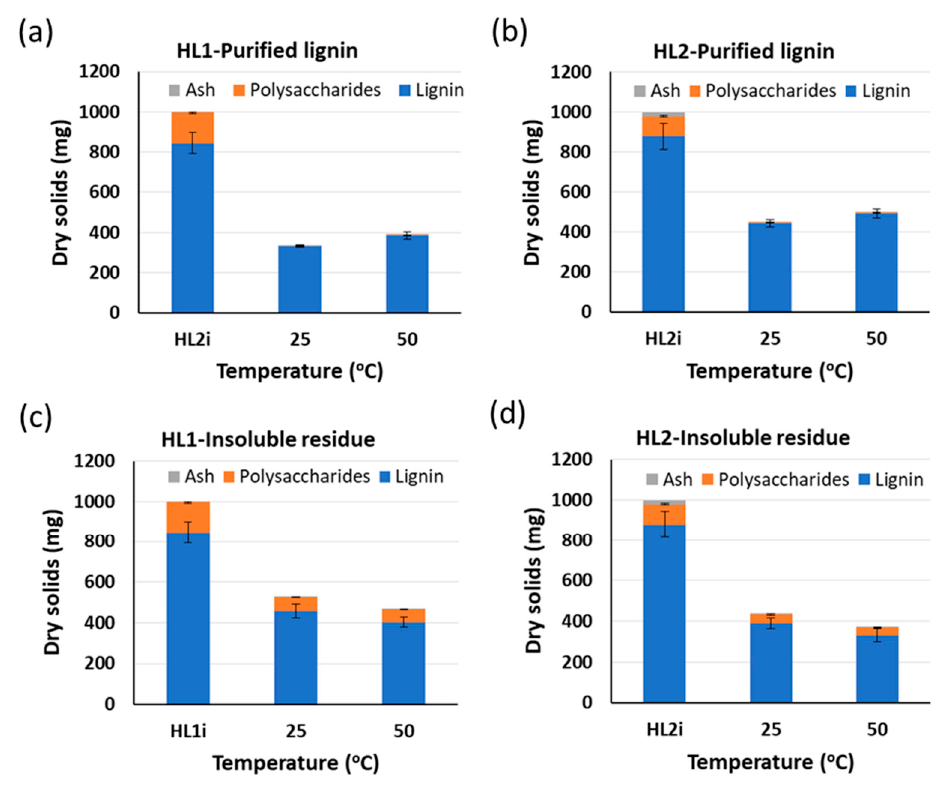
Figure 2. Influence of alkaline hydrolysis temperature on the composition of purified lignin (PL) for ( a ) HL1 and ( b ) HL2 lignins and insoluble residue (IR) for ( c ) HL1 and ( d ) HL2 lignins. Experiments are using 0.1 M NaOH and initial W lign = 0.03. HL1i and HL2i represent the initial lignins before the treatment. Standard deviation error bars of duplicate experiments.